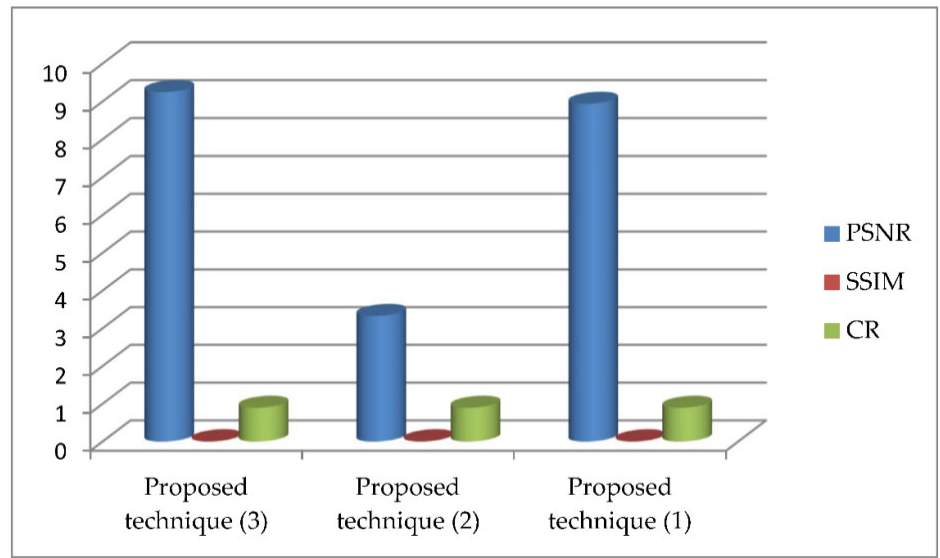
Figure 8. Comparison of PSNR, SSIM , and Cr for color airplane image for the three proposed techniques using DRPE